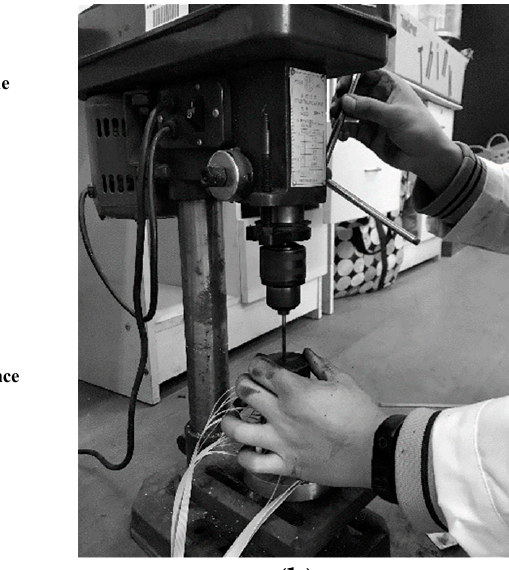
Figure 3. Diagram of the observation system used to measure self-potential ( a ) and photograph of drilling of the inner hole ( b ). 1#–32# stand for the electrode 1 to electrode 32.